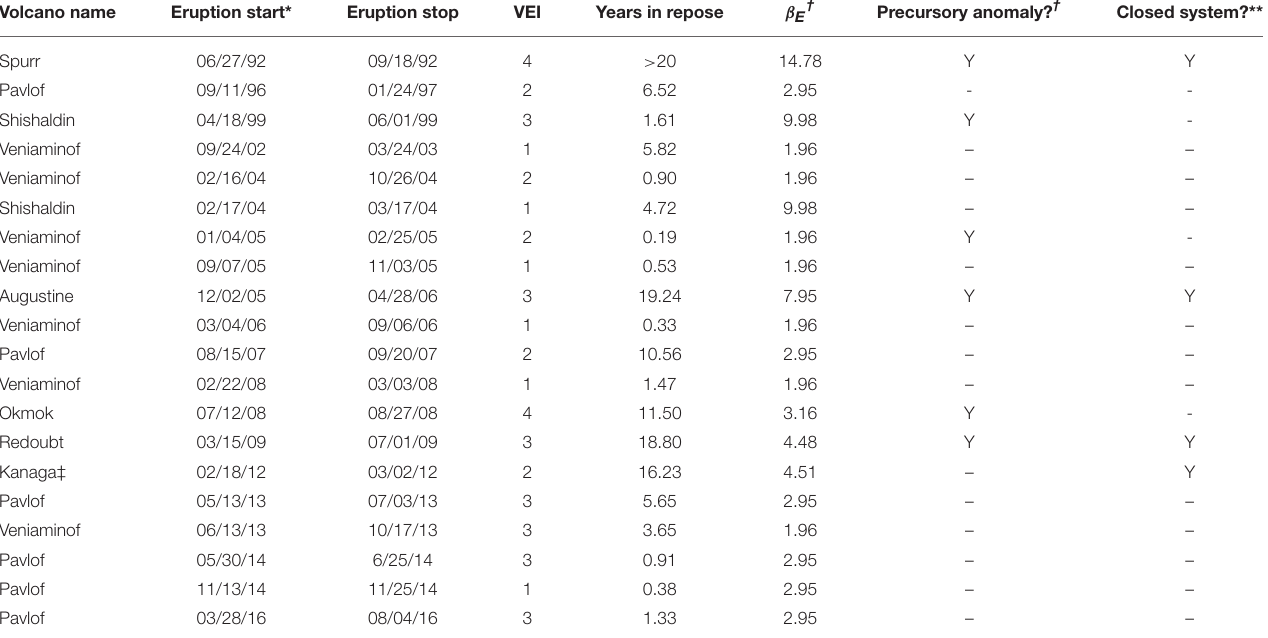
TABLE 1 | Eruption